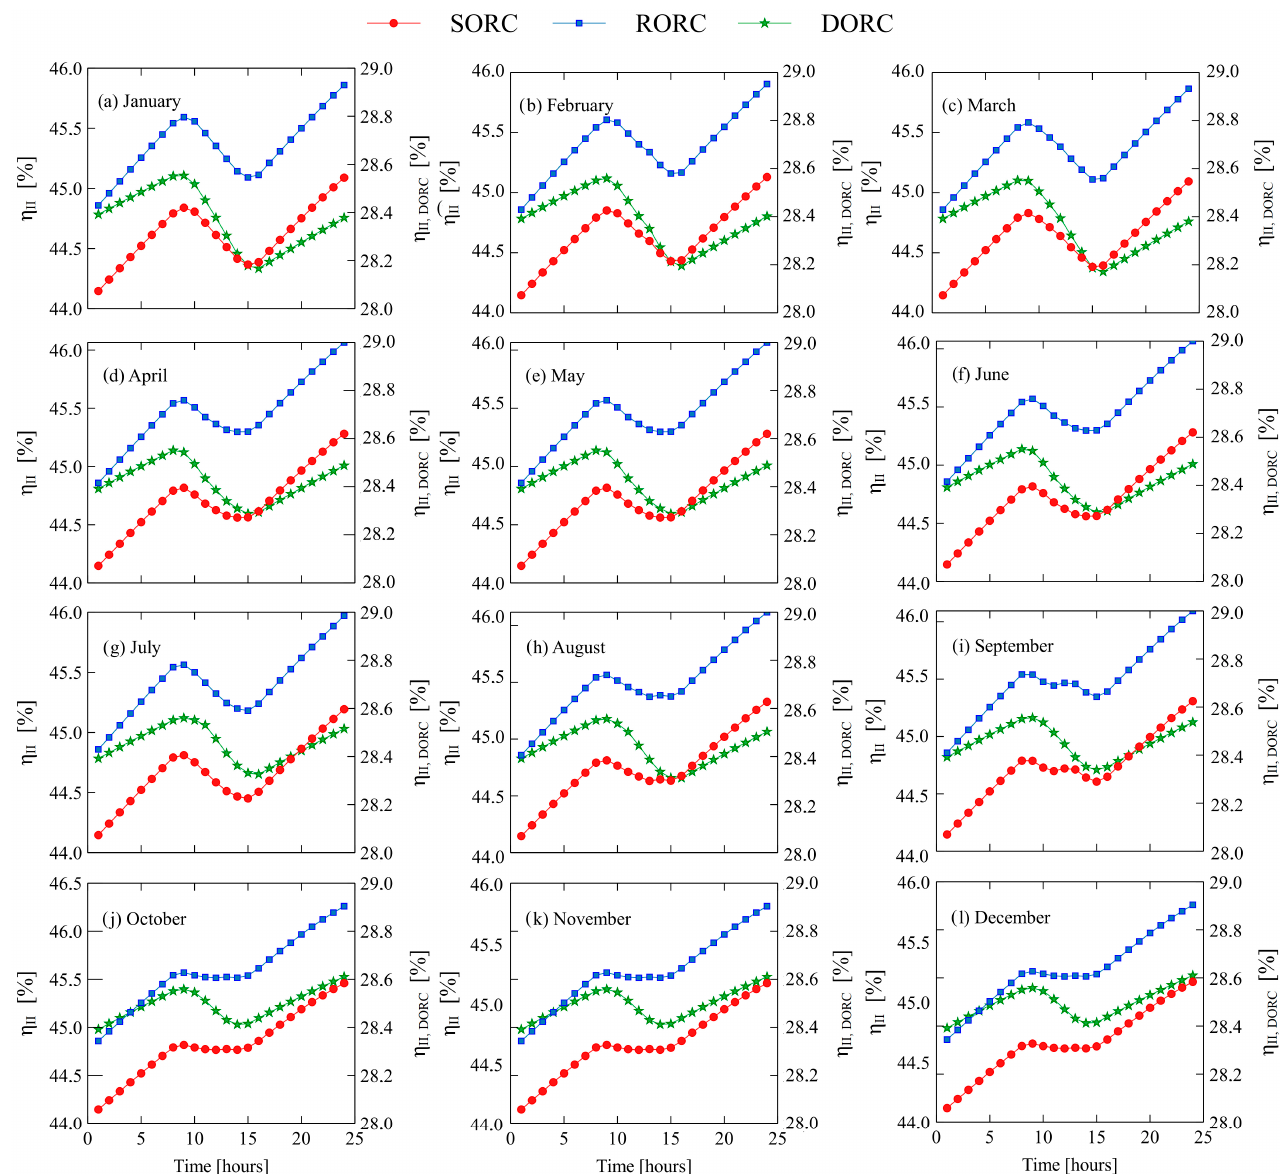
Figure 11. Variation of the exergetic efficiency of the configurations on a particular day of each month.